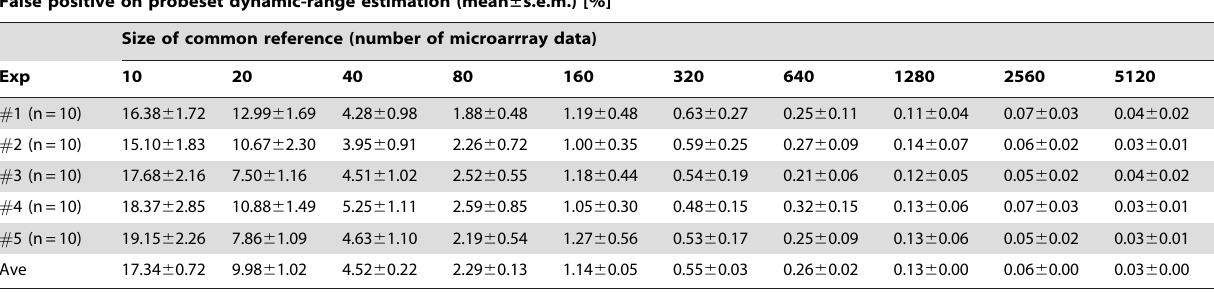
False positive on probeset dynamic-range estimation (mean ± s.e.m.) [%] Size of common reference (number of microarrray data)